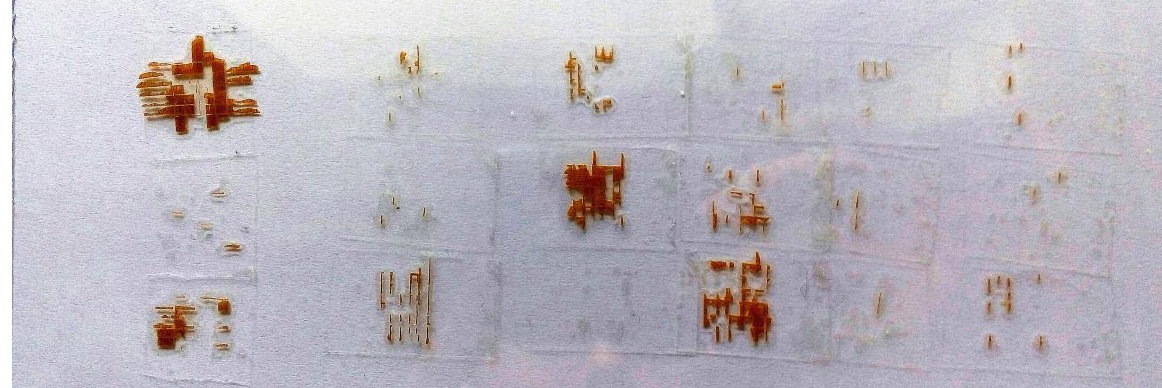
Figure 1. Transparent adhesive tape with paint film (Group B).